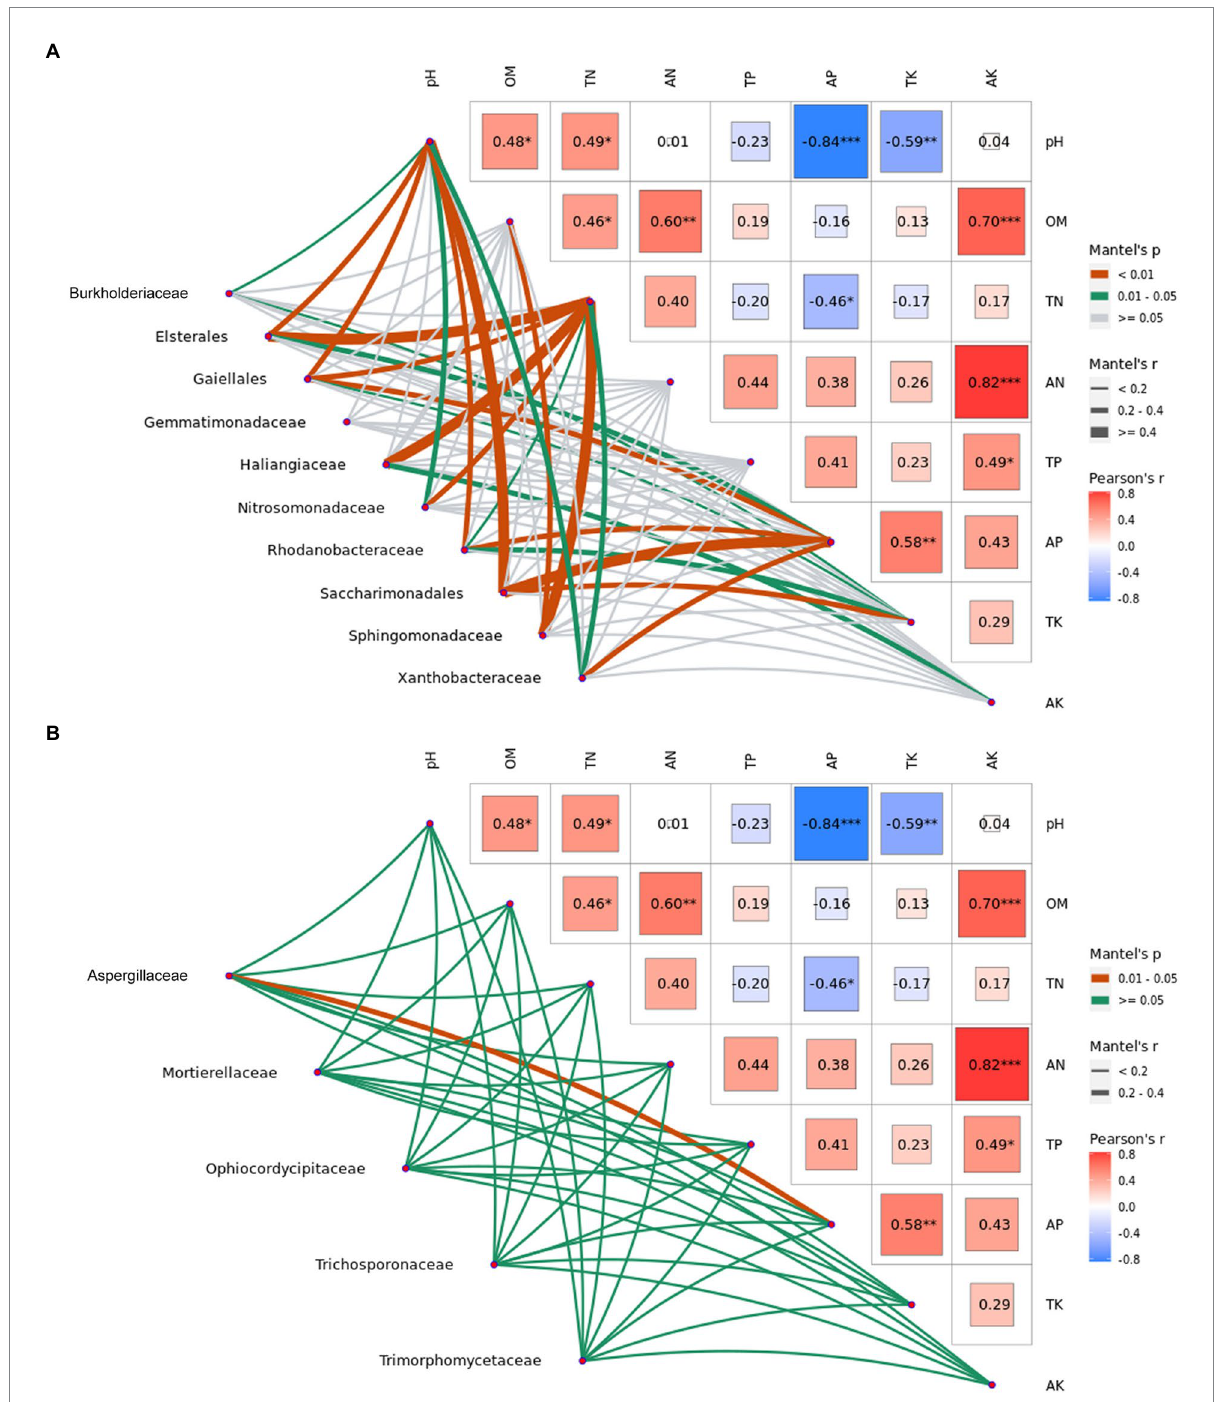
FIGURE 6 Mantel test of abundances of dominant bacterial and fungal family with significant difference analysis ( p < 0.05) at the harvest stages and the physicochemical properties in ginger soil. Elsterales, Gaiellales and Saccharimonadales are the uncultured bacterium. pH, potential of hydrogen; OM, organic matter; TN, total nitrogen; AN, hydrolytic nitrogen; TP, total phosphorus; AP, available phosphorus; TK, total potassium; and AK, available